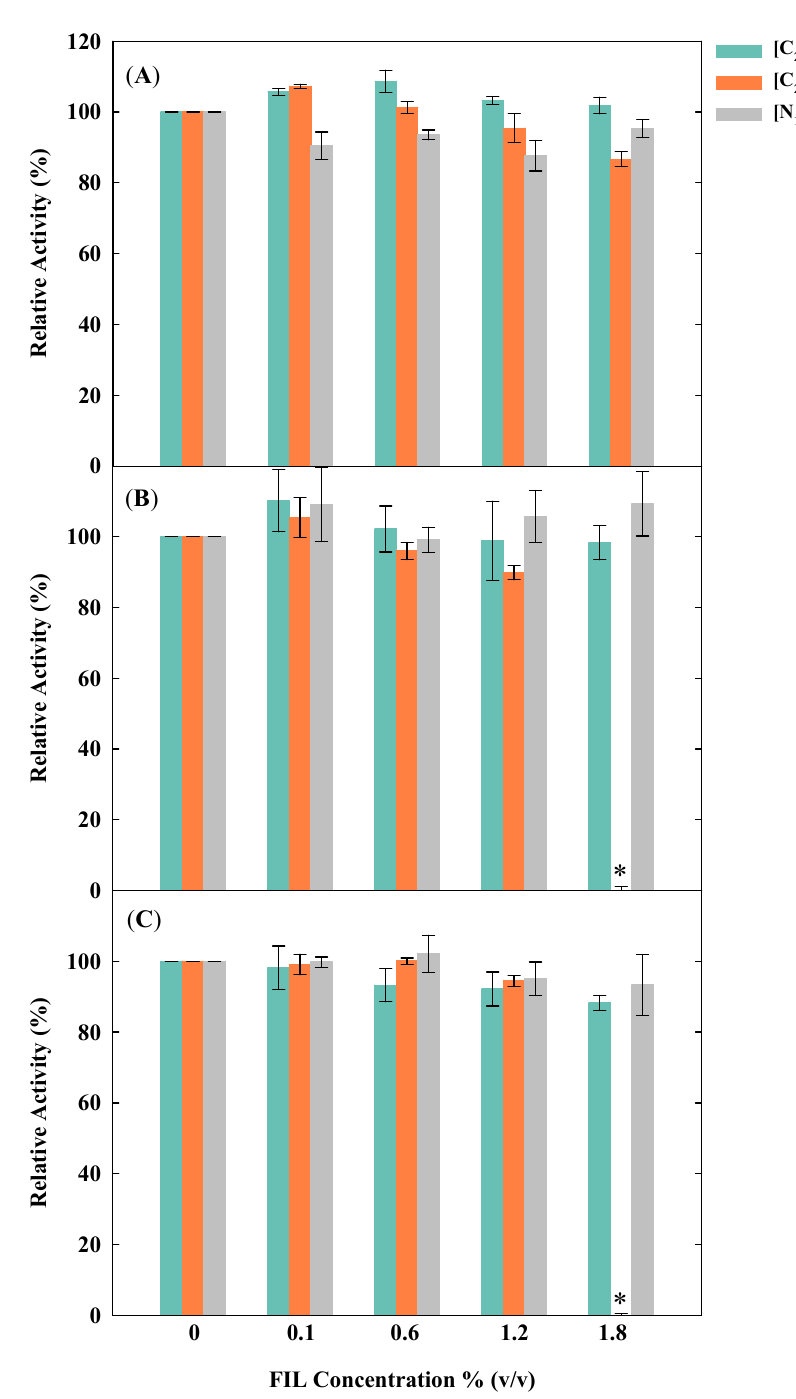
Figure 3. Lysozyme activity in di ff erent FILs concentrations at: ( A ) 4 ◦ C, ( B ) 25 ◦ C, and ( C ) 37 ◦ C. * Under these conditions the lysozyme activity is null. The error bars indicate the standard deviations of the mean values.